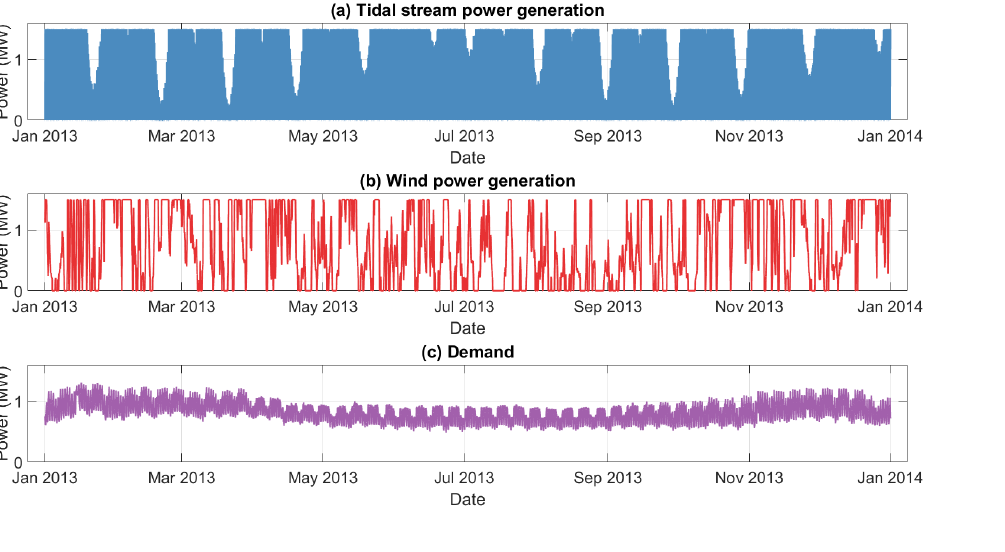
Figure 4. Annual power generation time-series from the ( a ) tidal stream turbine and (b) wind turbine, and ( c ) Alderney